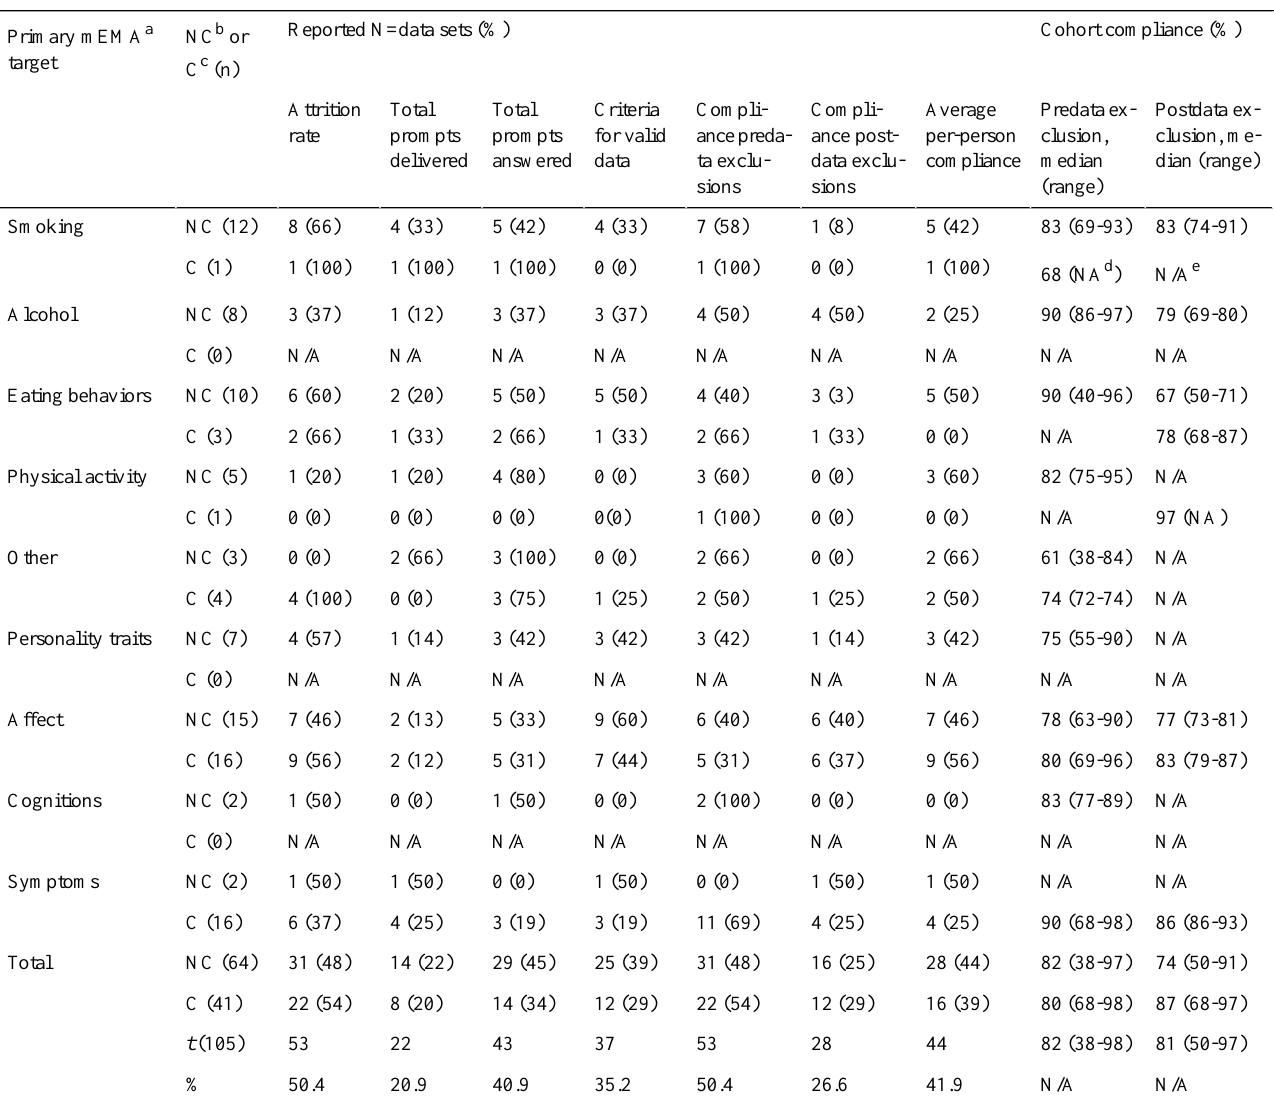
Table 1. Summary of mobile ecological momentary assessment (mEMA) compliance